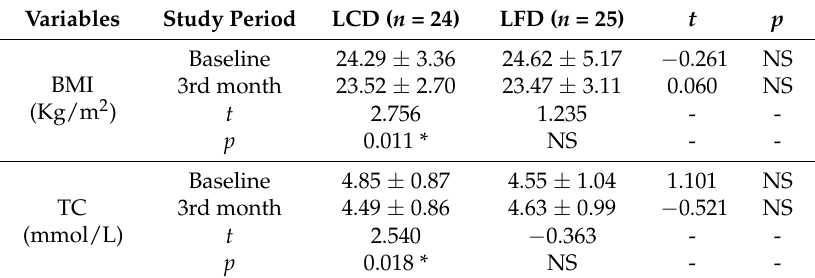
Table 8. Comparison of other metabolic indicators between the two groups.